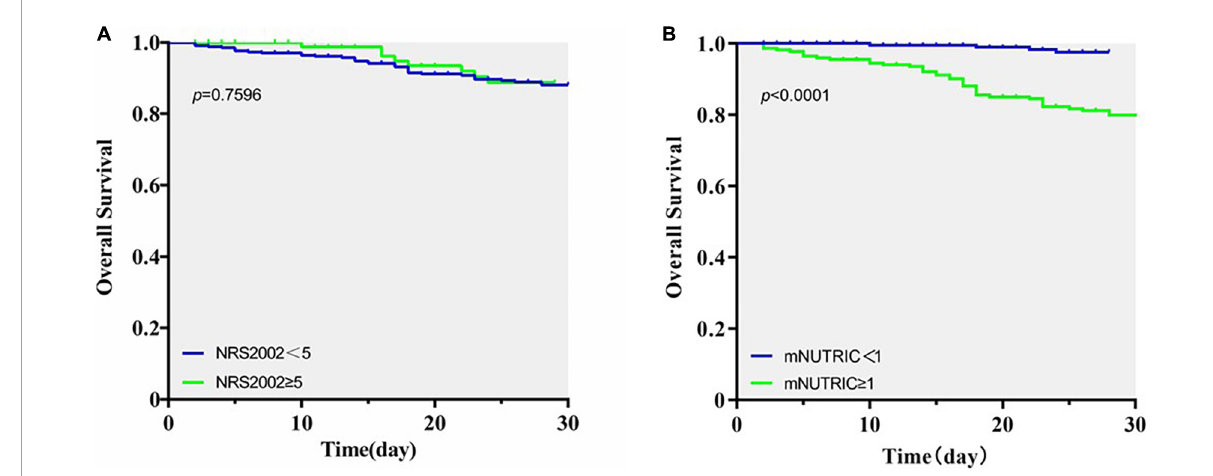
FIGURE3 Kaplan–Meier survival curves in severely burned patients. (A) Overall survival based on NRS2002 scores. (B) Overall survival based on mNUTRIC scores.